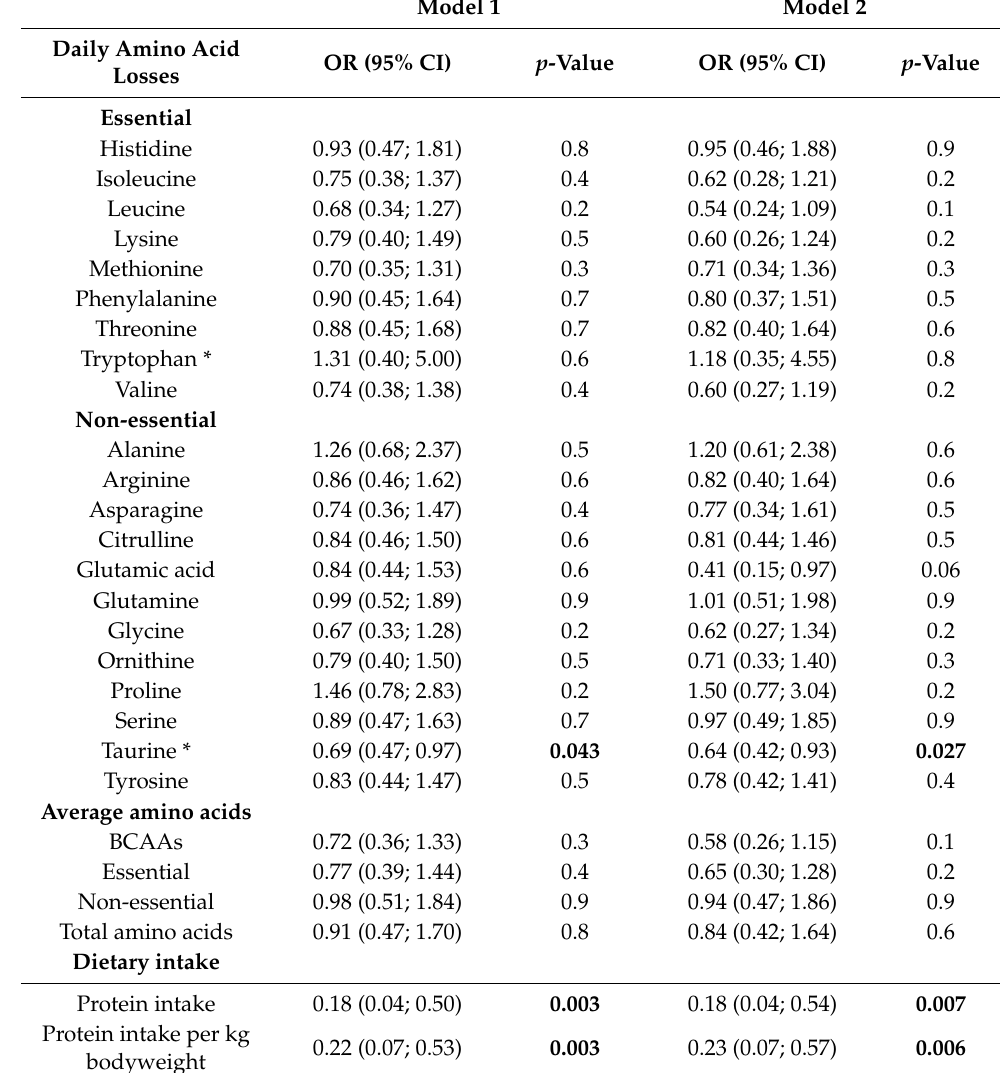
Table 6. Logistic regression analyses of daily amino acid losses and protein intake with severe